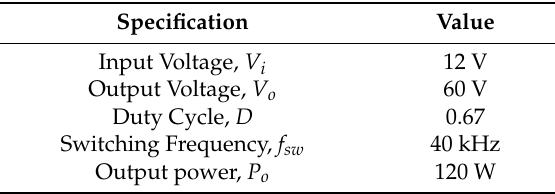
Table 3. Specifications of Converter Prototype.